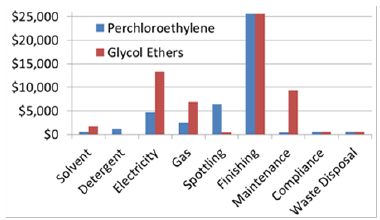
Figure 3. Cost comparison of annual operating costs using either PCE or GEs in dry cleaning